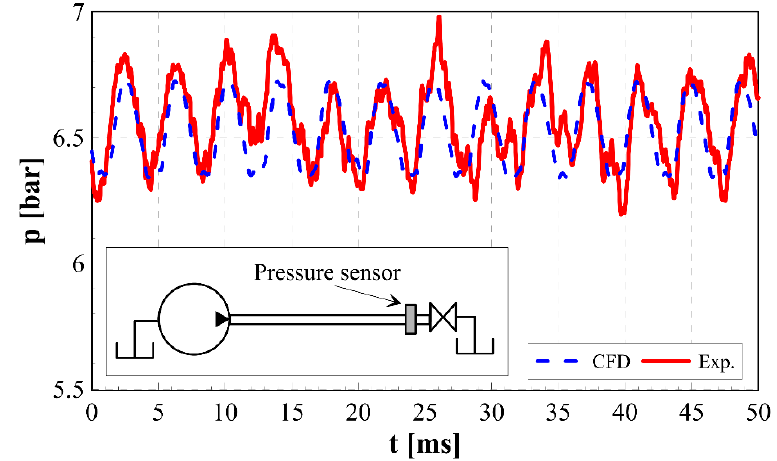
Figure 8. Pressure validation close to the pipe extremity (1200 rpm, 6.5 bar).